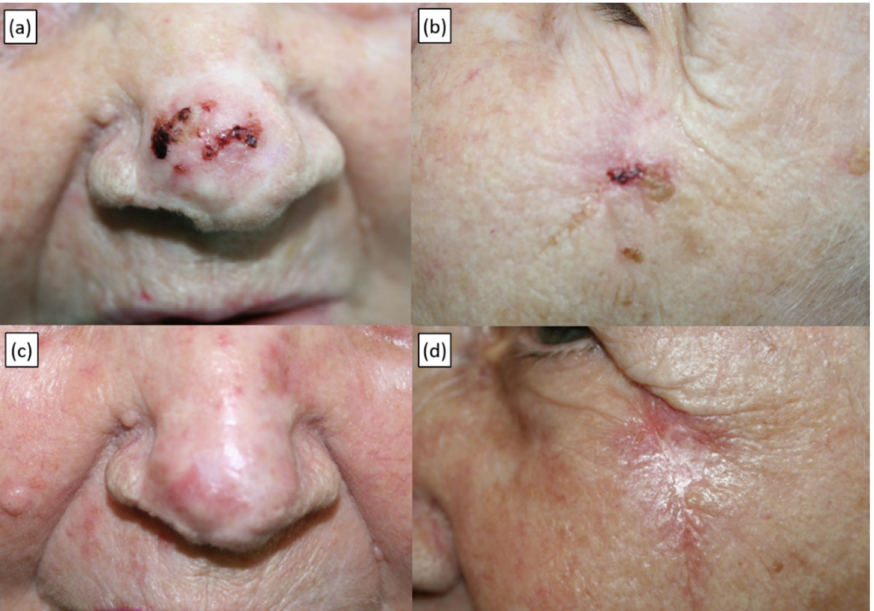
Figure 1. Recurrent BCC of the tip of the nose and concomitant primary BCC of the left zygomatic area in an 89-year-old patient treated with a single ECT application under local anaesthesia. ( a,b ) Baseline presentation. ( c,d ) Twelve-month follow-up showing a complete response.